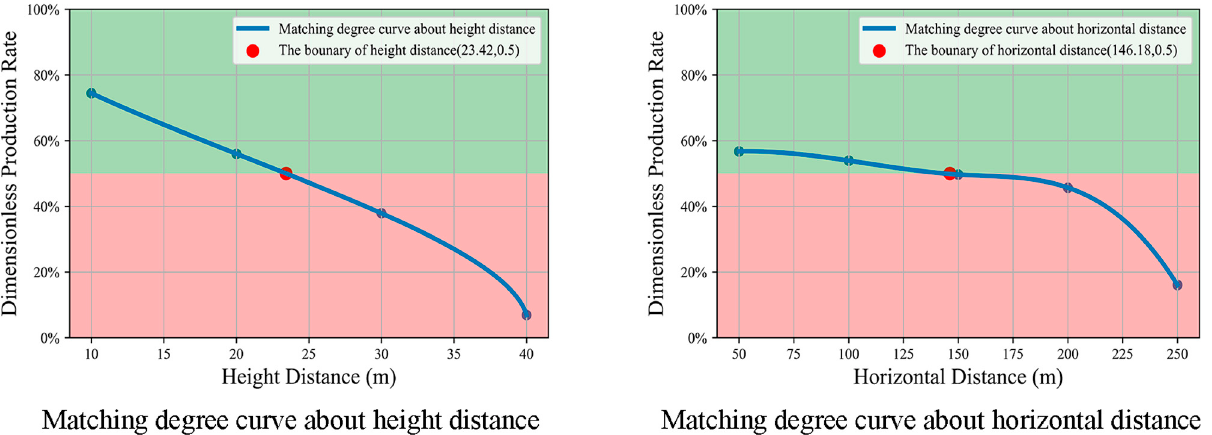
Figure 19. Matching degree curve for height distance and horizontal distance.